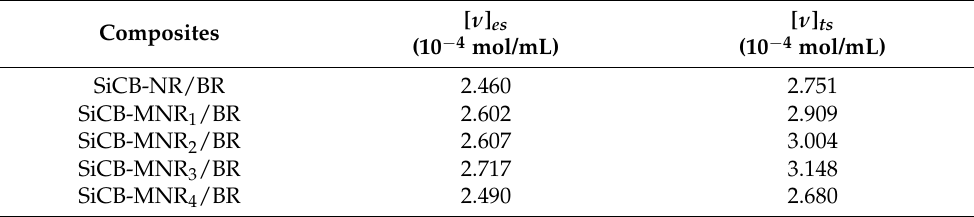
Table 2. Crosslinking densities determined from both equilibrium swelling and tensile